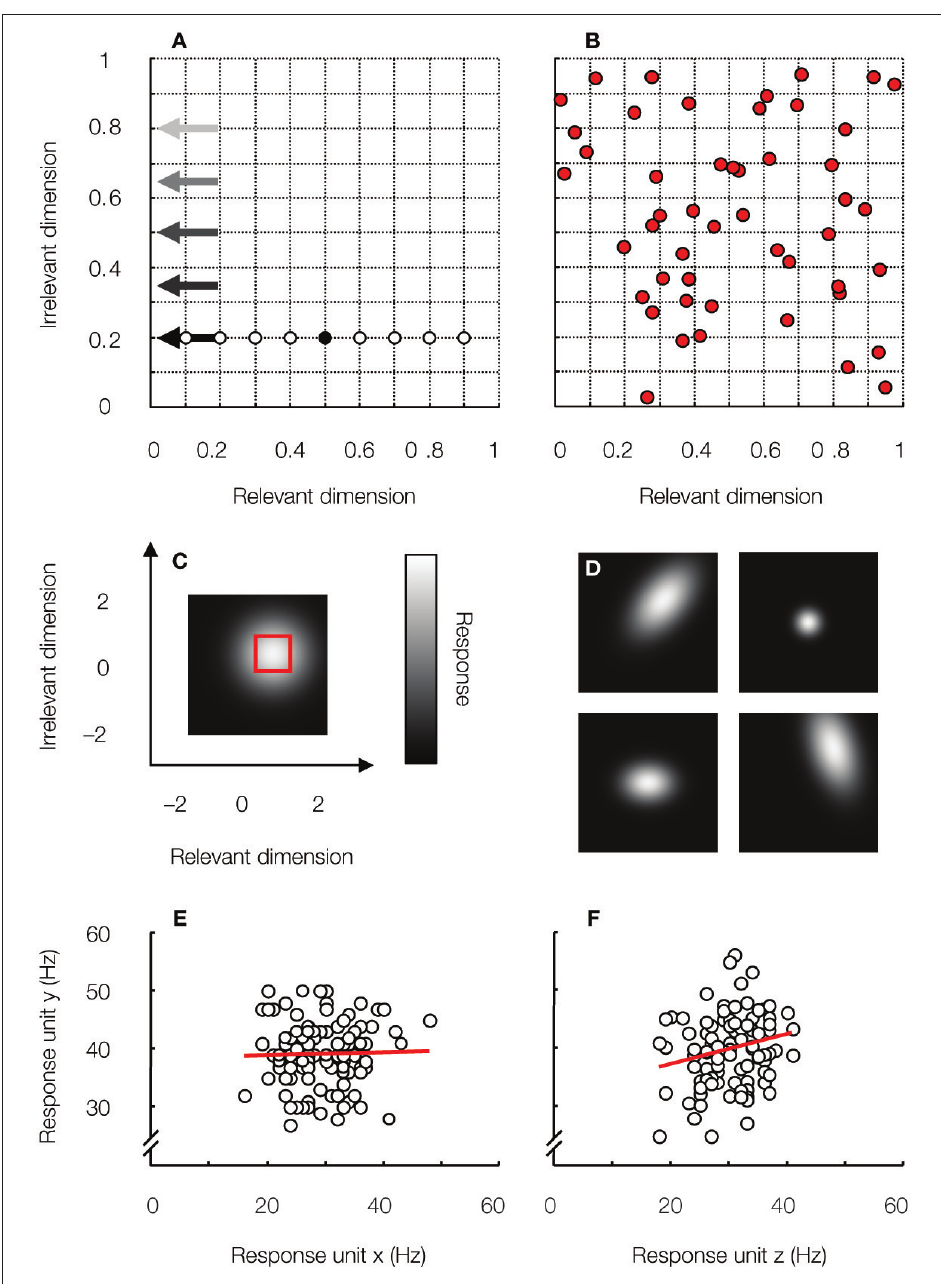
Figure 3 | Task and network characteristics studied in the simulations. (A) Design of the identification experiment. A linear classifier was trained to discriminate a 2-D target stimulus (black symbol) from a 2-D distracter – randomly selected from a set of eight distracters (white symbols) on each trial – using the responses of a simulated pool of IT-neurons as input. After training, classification performance of the network was tested in five identification tasks, each characterized by the test stimuli’s location on the irrelevant dimension (indicated by the arrows; lighter arrow colors correspond to a larger test-training difference on the irrelevant dimension). (B) Preferred stimulus location was sampled randomly from a bivariate uniform distribution – red square in (C) – for each unit in the network. The distribution of preferred stimulus locations is shown for one particular network. (C) Each network unit is characterized by a 2-D Gaussian-shaped tuning function. This unit is broadly tuned to both stimulus dimensions. Tuning width and dependence was manipulated in the simulations. (D) Some example unit tuning functions. (E) To mimic neural noise, unit responses varied across stimulus presentations. Responses of one unit to 100 stimulus presentations are plotted as a function of the responses of another unit to the same stimuli. These units share no noise. In the nervous system, responses of cortical neurons are typically weakly correlated (Zohary et al., 1994), as shown in (F) . This characteristic was shown to impair tolerance by Goris and Op de Beeck (2009). For further details on the methods, the reader is referred to this